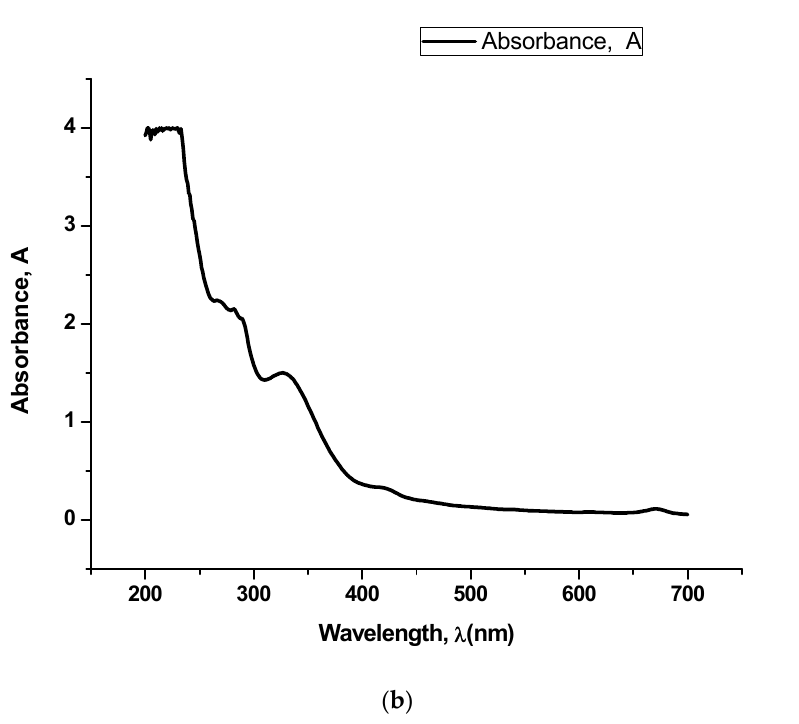
Figure 2. ( a ) FTIR spectra of Harmal leaves before and after extraction. ( b ) UV-visible spectra of Harmal extract aqueous solution.